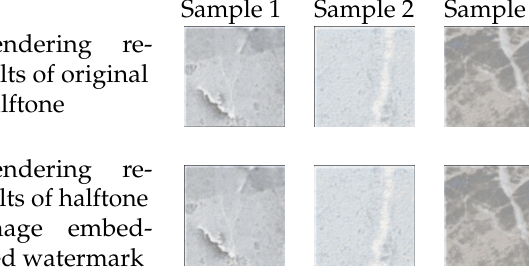
Figure 12. Comparison of the results of the original halftone image and the halftone image generated by our